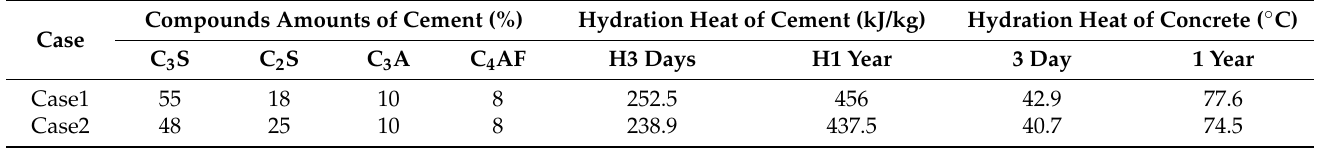
Table 3. Concrete hydration heat as a function of the change in the cement compound